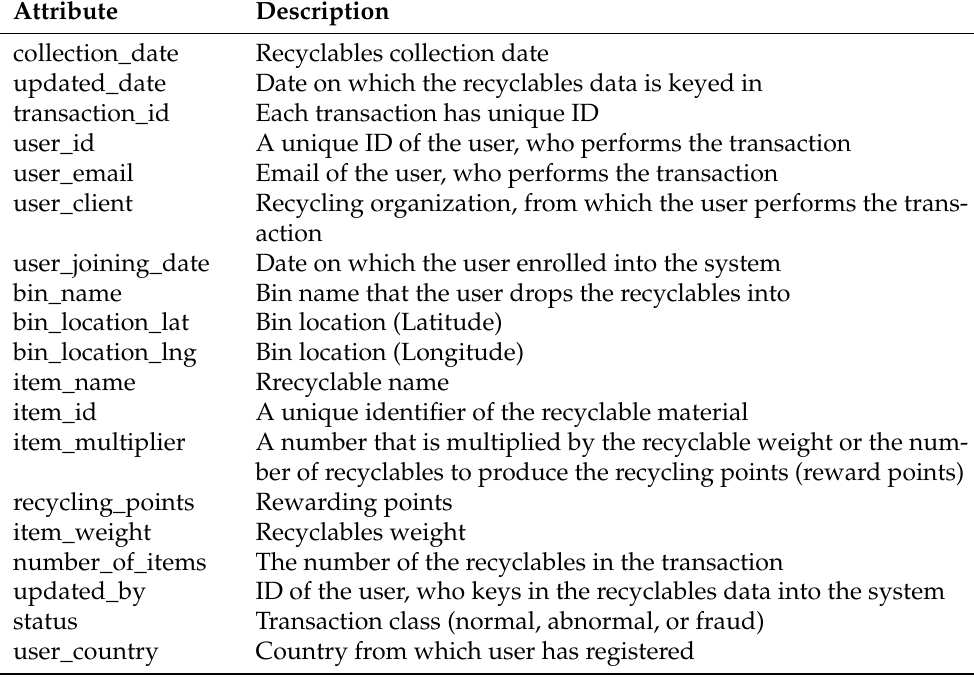
Table 1. Dataset